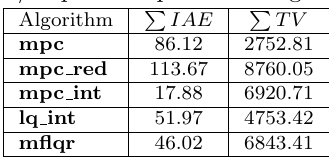
Table 1: The table shows the combined (surge-sway) mean Integral Absolute Error indices (cid:80) IAE (Eq. (30)) and mean Total input Value (Eq. (31)) for mpc , mpc red , mpc int , lq int and mflqr algorithms corresponding to refer- ence/setpoint response in surge and sway.